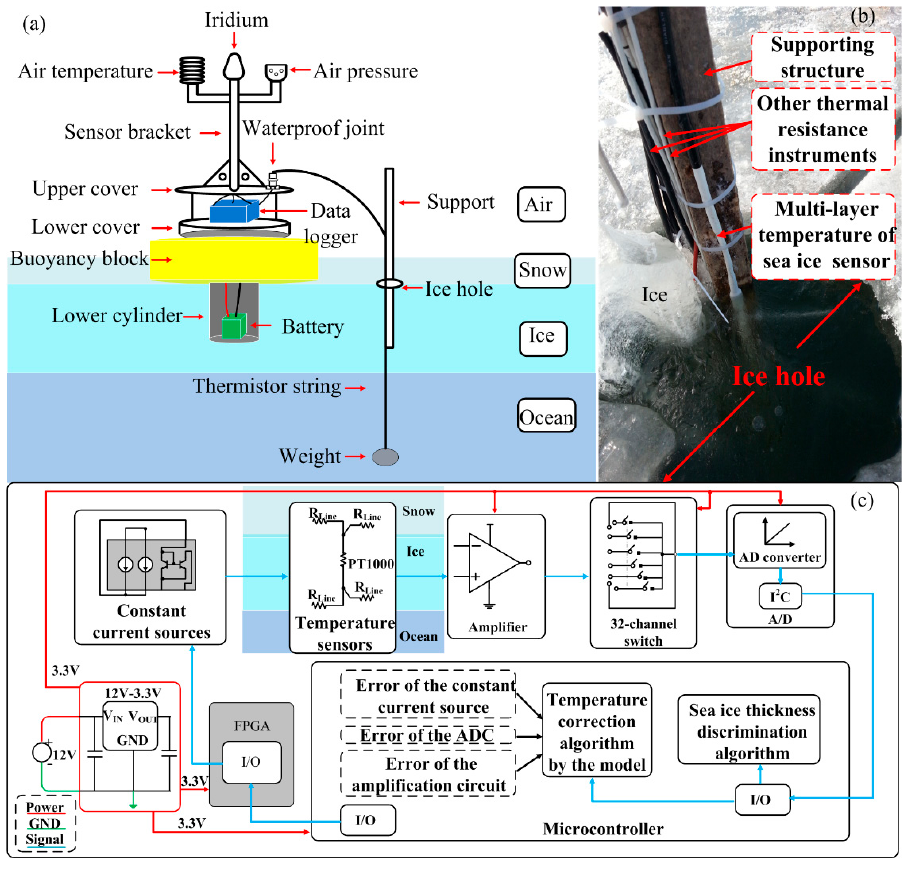
Figure 1. ( a ) System composition of the proposed multilayer sea ice temperature sensor. ( b ) The multilayer sea ice temperature sensor and other thermal resistance instruments installed in Wuliangsuhai, Yellow River in 2018. ( c ) Block diagram of the multilayer sea ice temperature sensor.